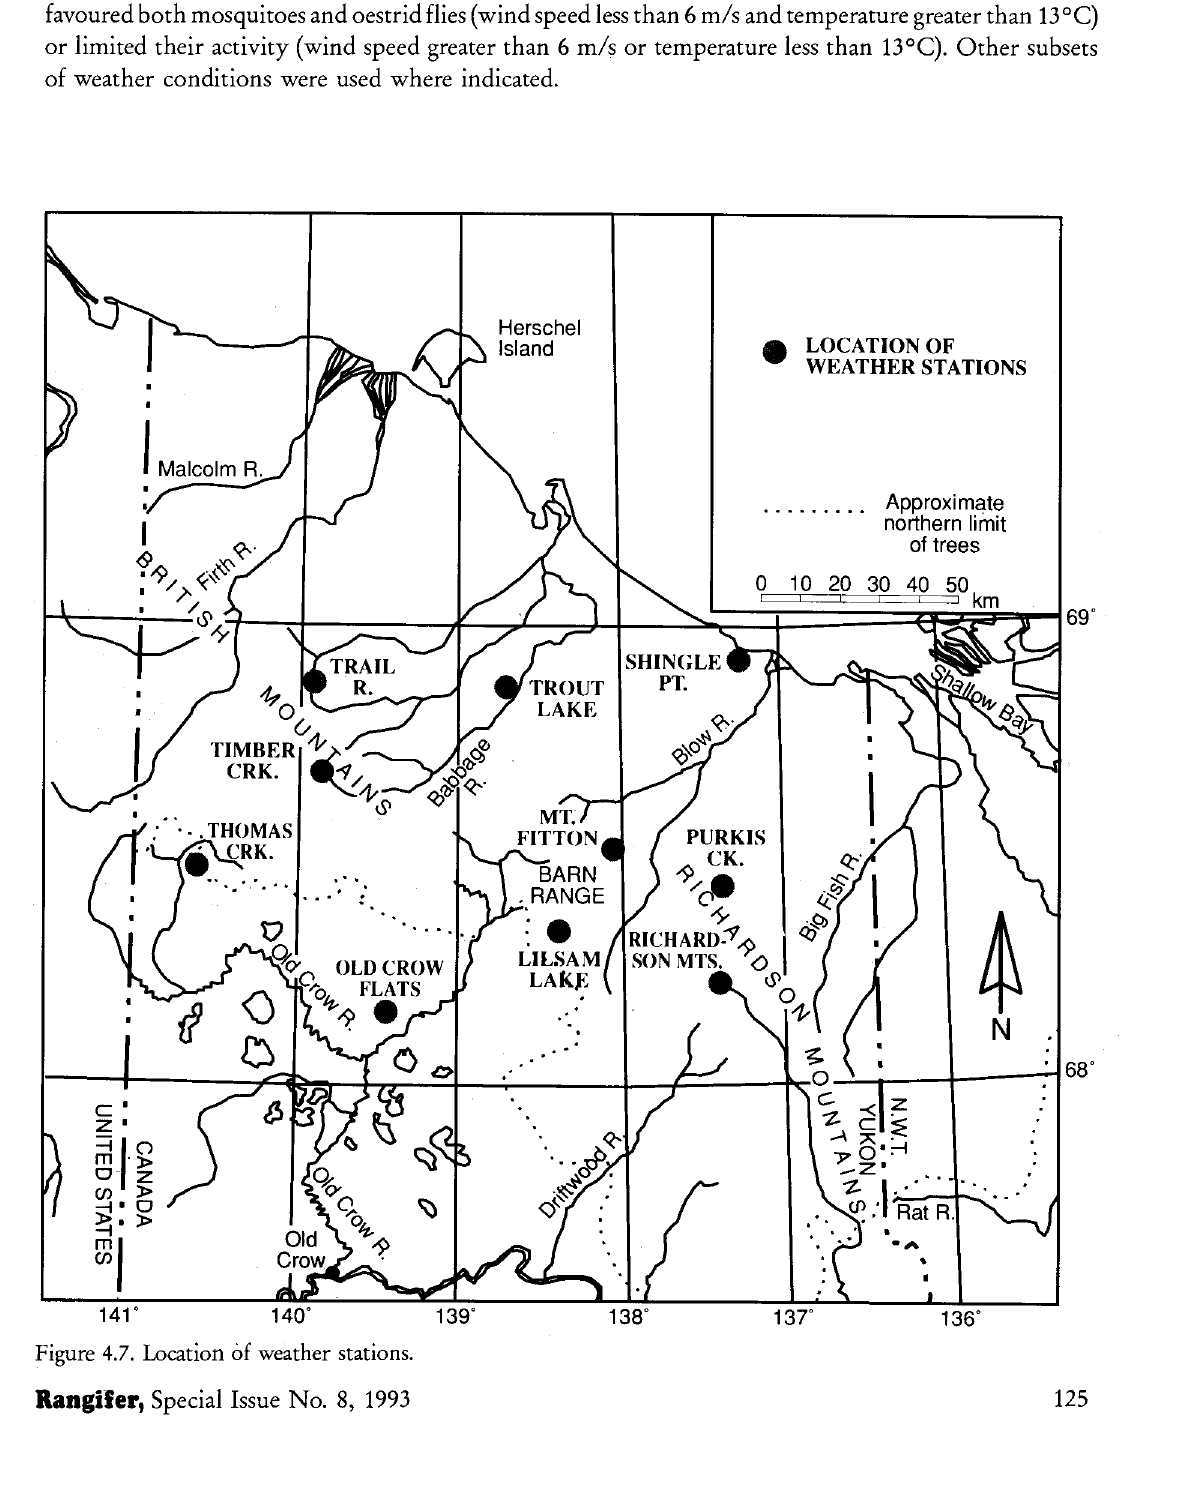
Figure 4.7. Location of weather